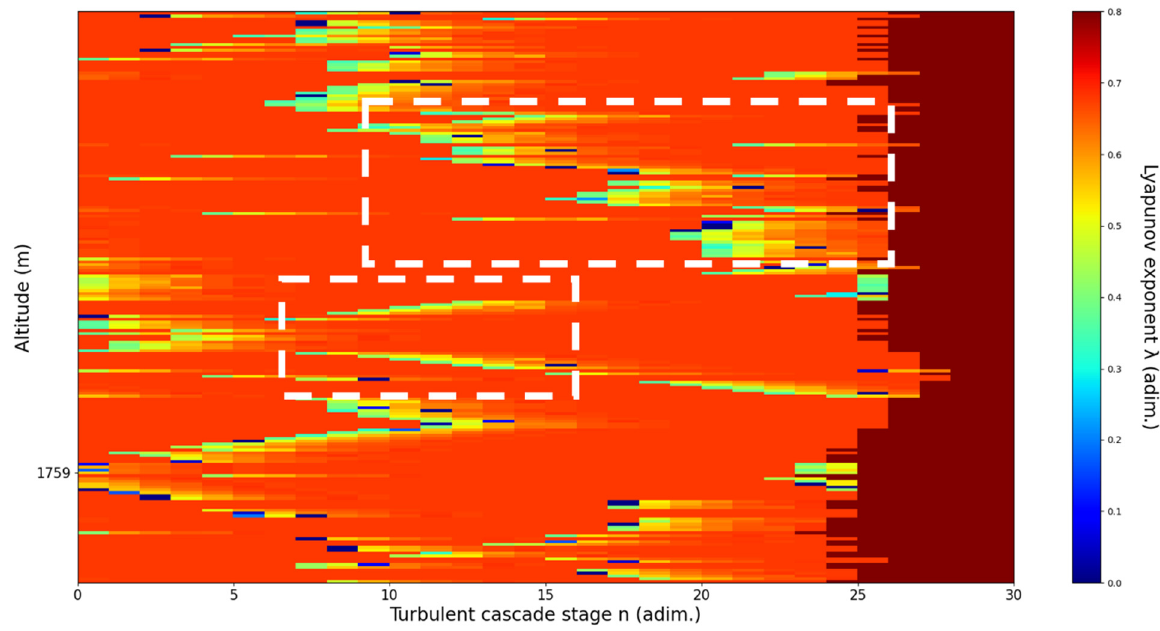
Figure 17. Lyapunov exponent per turbulent cascade stage colormap altitude plot, Bucharest, Romania, 13 June 2019,